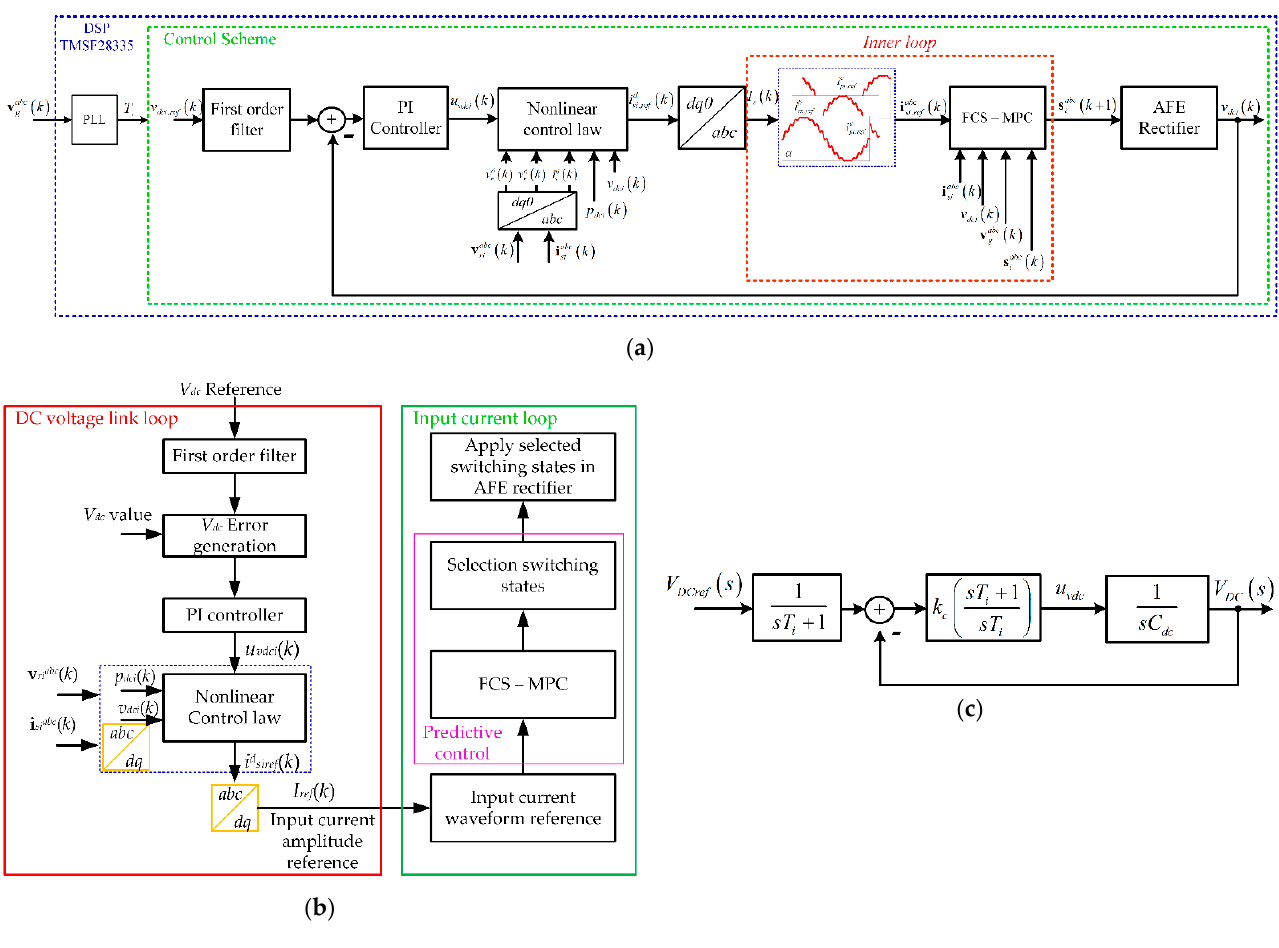
Figure 3. Control scheme in each power cell: ( a ) master-slave control scheme, ( b ) flow chart control scheme, ( c ) nonlinear control DC voltage with a filter.